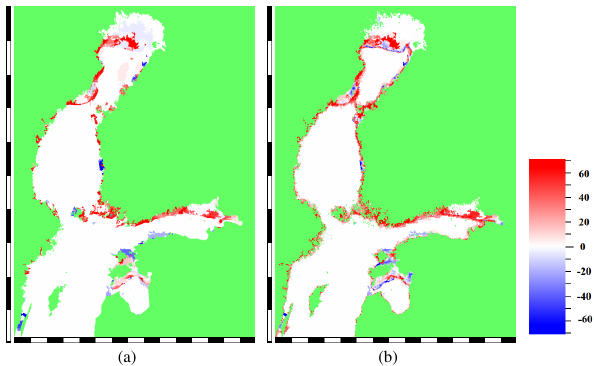
Figure 7. Difference between our algorithm result and FMI ice chart concentration for 11 February 2014 (a) and between our re- sult and ASI concentration (b) . Overestimation produced by our al- gorithm with respect to the reference data is indicated by the blue tones (negative difference values) and underestimation by red (pos- itive values). In the image scales the interval is 1 ◦ in both latitude and longitude; the upper left corner is located at 66 ◦ N, 16 ◦ E, and the lower right corner is located at 56 ◦ N, 31 ◦